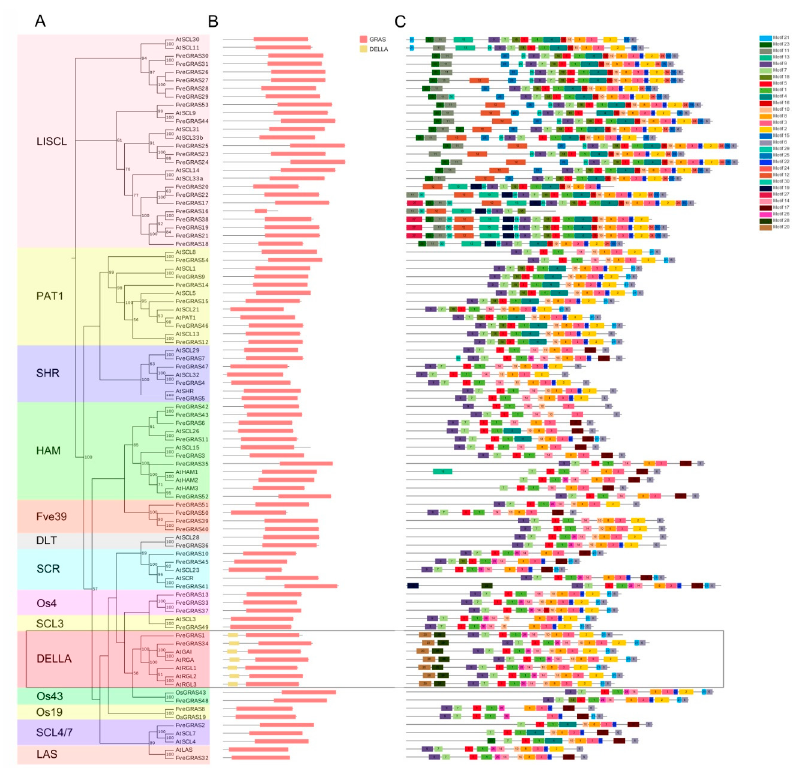
Figure 2. Domain and motif compositions of GRAS proteins from Arabidopsis thaliana and woodland strawberry. ( A ) Phylogenetic tree of GRAS proteins in Arabidopsis thaliana and woodland strawberry. Di ff erent subfamilies are marked with di ff erent color backgrounds. ( B ) Domain compositions of GRAS proteins from Arabidopsis thaliana and woodland strawberry. Red boxes represent GRAS domains, and yellow boxes represent DELLA domains. Domains were identified by Pfam website. ( C ) Motif compositions of GRAS proteins from Arabidopsis thaliana and woodland strawberry. Motifs were identified by MEME software, up to 30 motifs were permitted and other parameters were default settings. Thirty motifs are indicated by di ff erent color boxes. The distribution of conserved motifs is presented in Supplementary Table S2. The black rectangle represents DELLA subfamily.